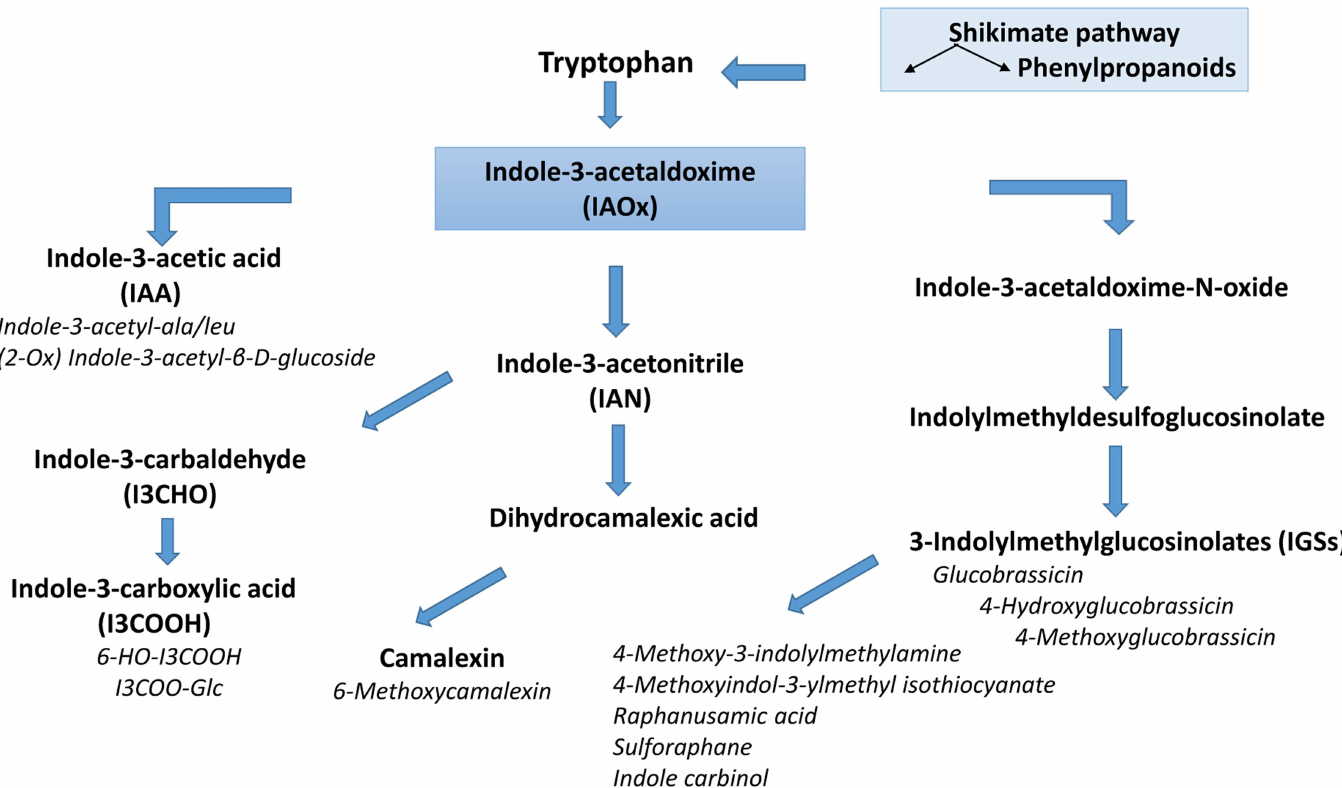
Fig 6. The indolic metabolite footprint of LPS-triggered signalling in Arabidopsis. In response to LPS perception, enhanced activity of CYP79B2/B3 (Beets et al. 2012) converts Trp and lead to the accumulationof indole-3-acetaldoxime (IAOx), the common precursor of indole glucosinolates (IGSs), indole phytoalexins (camalexin), indole-3-carboxaldehyde (I3CHO), indole-3-carboxylic acid (I3COOH) and indole acetic acid (IAA). Associated derivatives and conjugatesare indicatedin italics. The antimicrobial roles of the annotatedmetabolites ( e . g . phytoalexins, phytoanticipins and primingagents) and the metabolicinterrelationships are discussedin the main